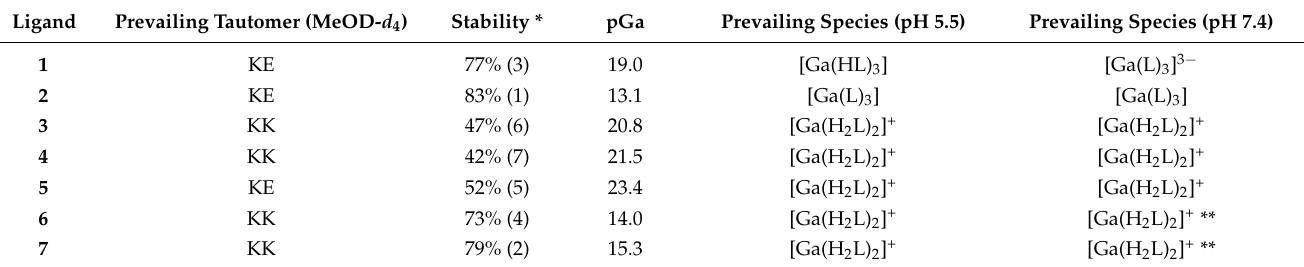
Table 4. Summary of chemical features. * Percentage of the residual ligand after 4 h (ranking). ** Possible formation of gallium hydroxide species.